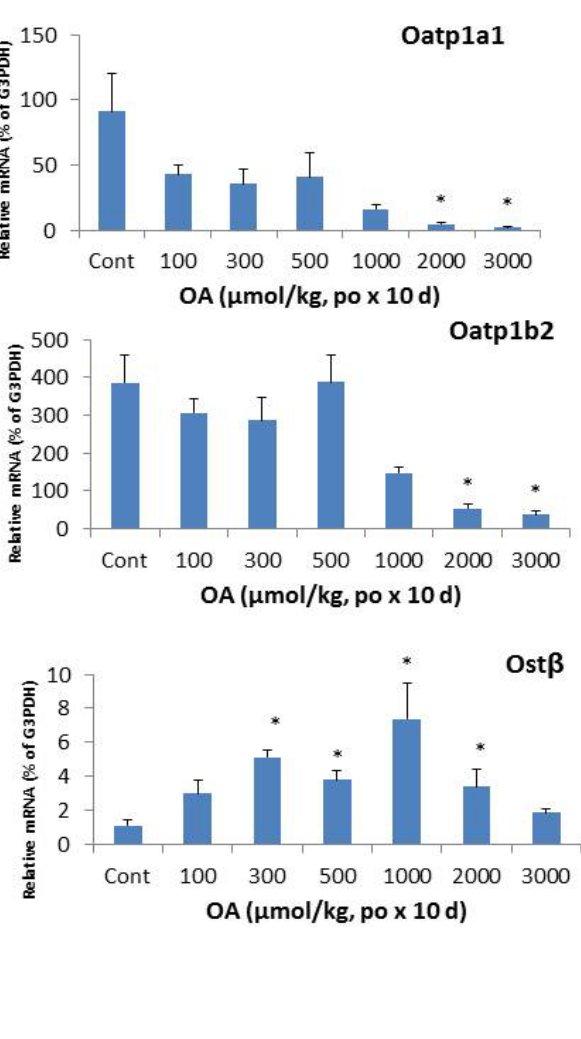
Figure 6. Expression of hepatic transporters. Mice were gavaged OA at doses of 100–3,000 µmol/kg (equal to 45–1,350 mg/kg). Twenty-four hours after the last